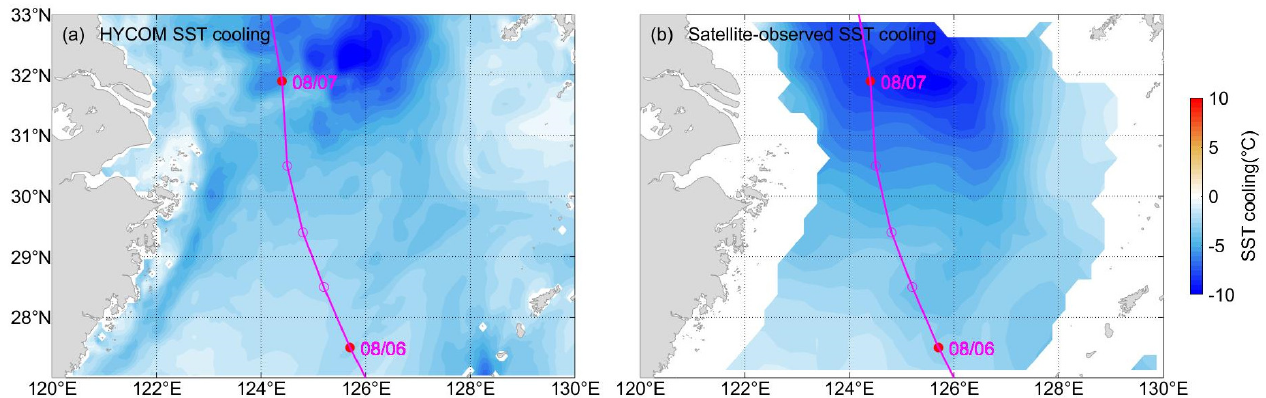
Figure A1. SST cooling caused by typhoon Muifa; ( a , b ) correspond to the HYCOM reanalysis results and satellite observations, respectively.